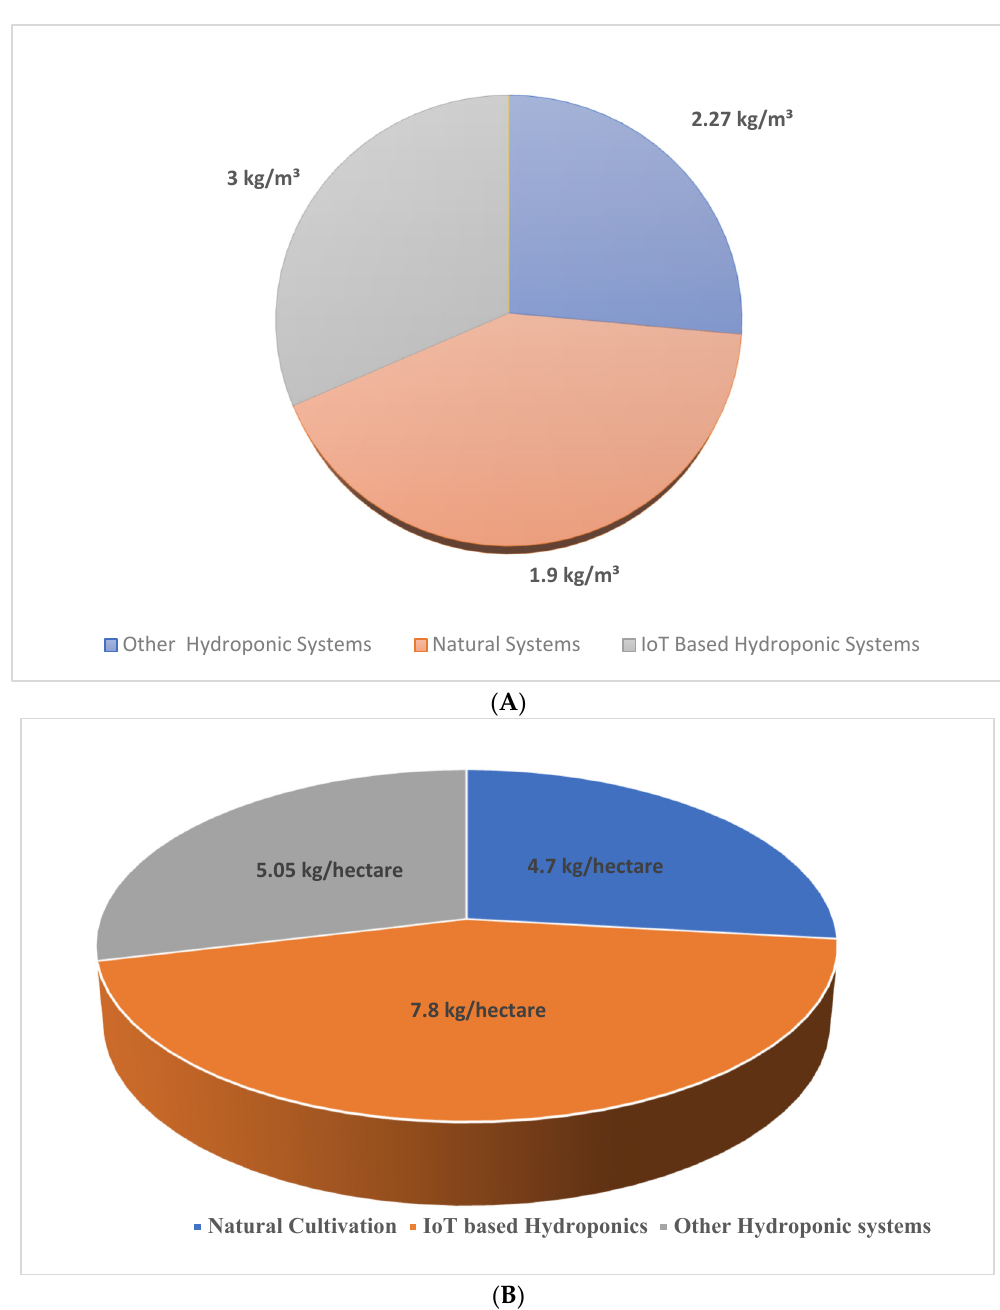
Figure 13. ( A ) Comparison of water productivity in different saffron cultivation models.( B ) Comparison of yield in different saffron cultivation models .